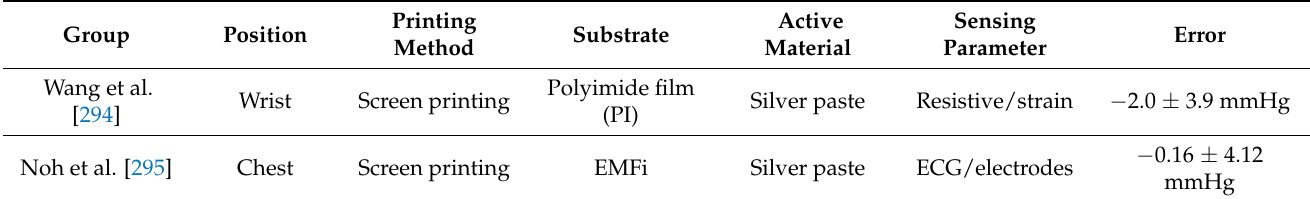
Table 5. A comparison of continuous printed blood pressure monitoring